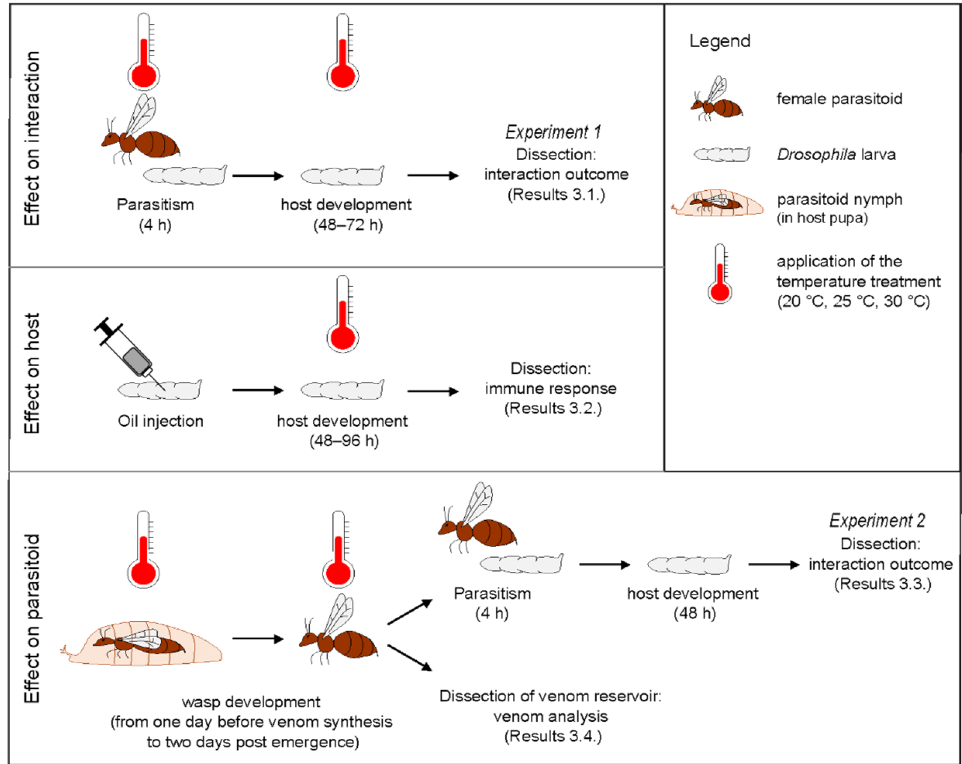
Figure 1. Schematic illustration of the experimental designs. A thermometer indicates where different temperatures (20 °C, 25 °C or 30 °C) were applied, while the absence of a thermometer means that the step was performed at 25 °C.